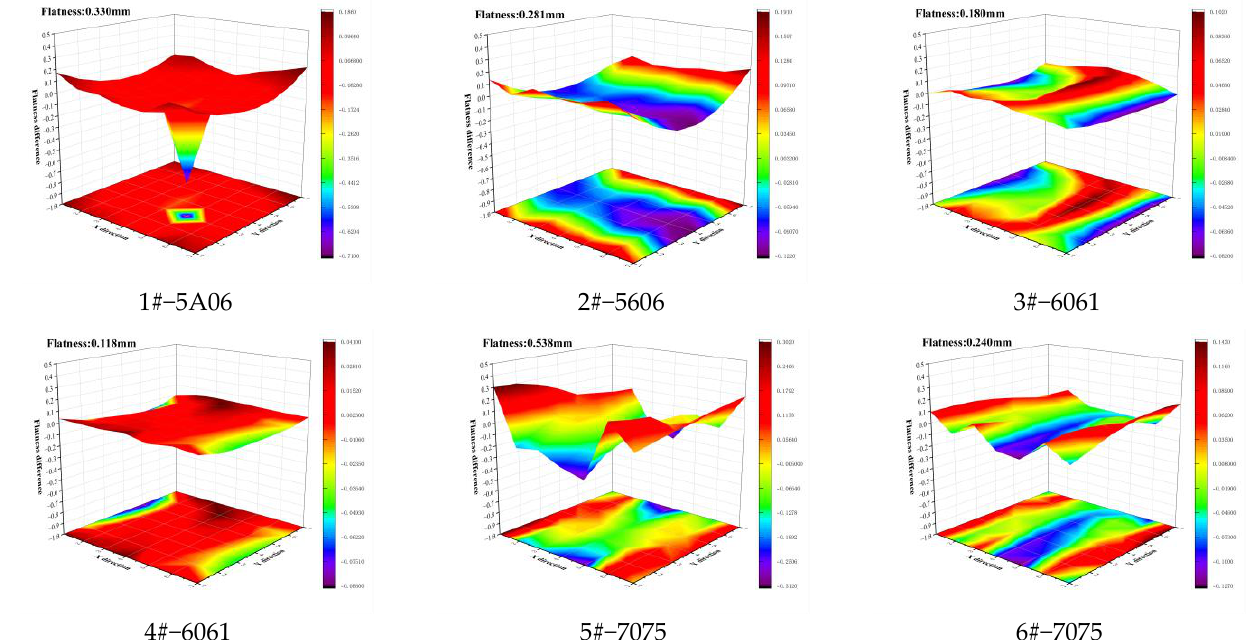
Figure 7. Plate deformation cloud after unilateral milling 1 mm.